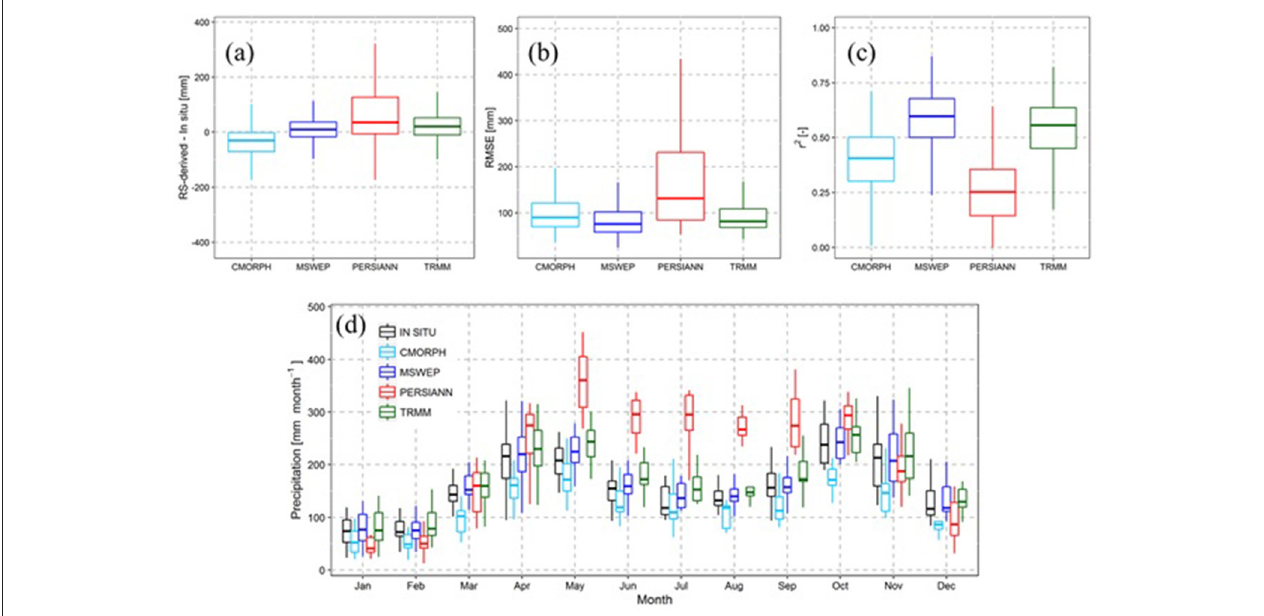
FIGURE 3 | Boxplots of (a) the difference, (b) RMSE , and (c) r 2 between monthly satellite-based precipitation at 25km resolution and observed precipitation for the 502 validation weather stations. (d) Boxplot of climatology of monthly satellite-based and observed precipitation at 25km resolution (average of 502 validation weather